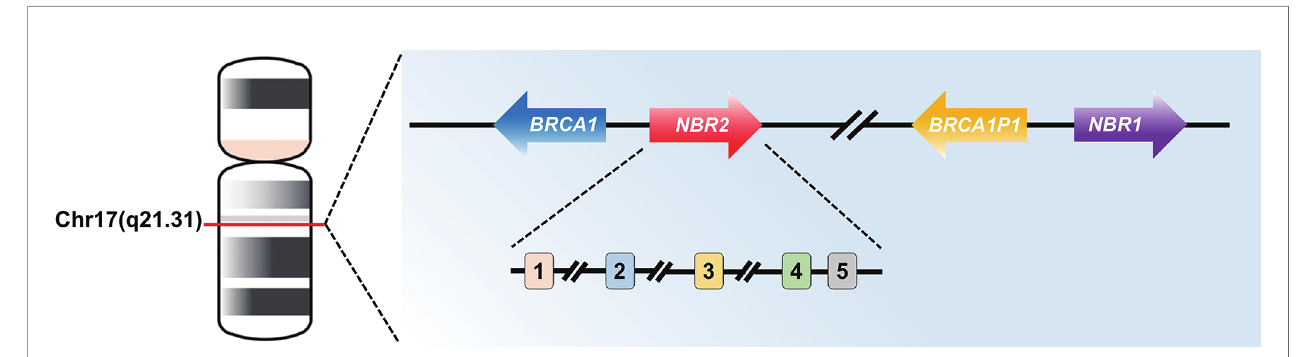
FIGURE 1 | Localization and genomic structure of the human NBR2 gene. Schematic diagram of the human NBR2 gene, with arrows indicating the direction of transcription and rectangles representing the exons. Genes are not drawn to